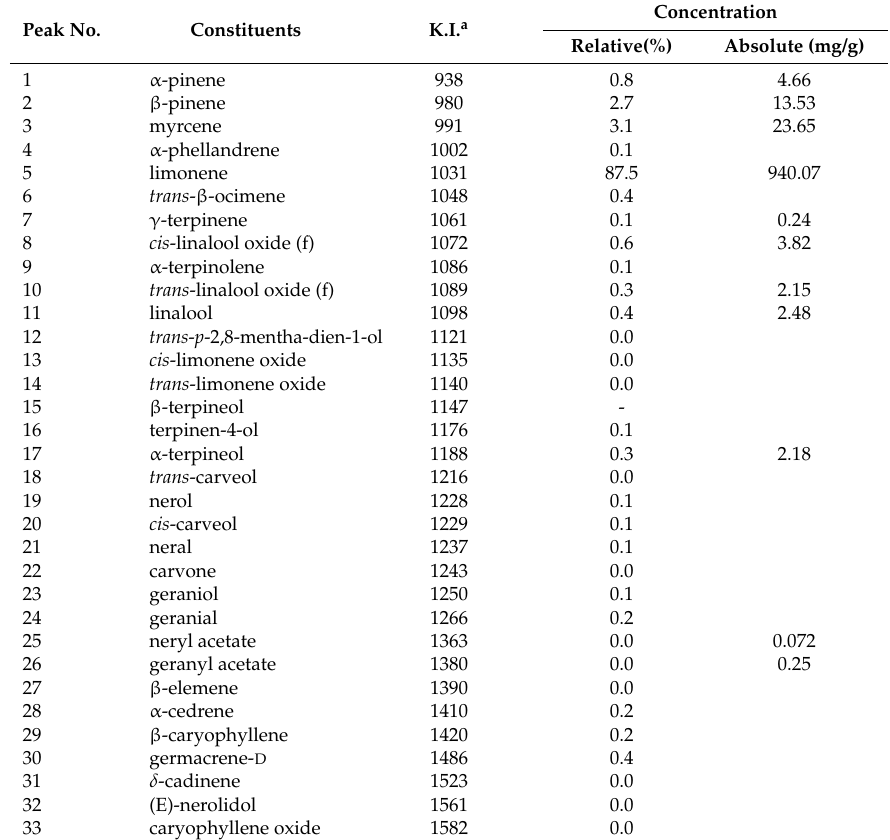
Table 1. Constituents of pomelo peel oil isolated by steam distillation.